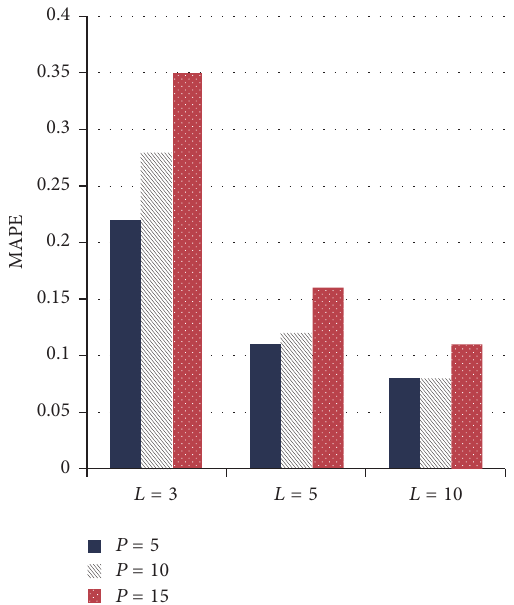
Figure10:Meanabsolutepercentageerror(MAPE)fromestimating 60 delay cases using different input time window sizes 𝐿 (minutes) and prediction horizons 𝑃